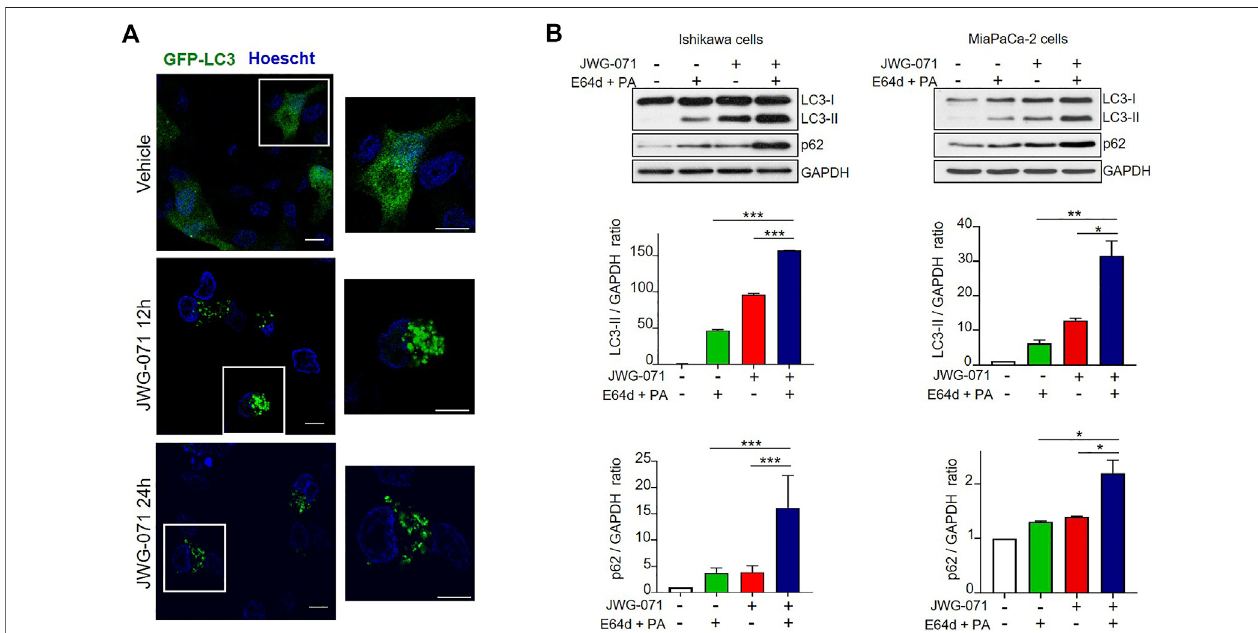
FIGURE 2 | ERK5 inhibition induces autophagic fl ux. (A) ERK5 inhibition induces LC3 association with autophagosomes. HeLa cells transiently expressing GFP- LC3 (green) were treated with vehicle or 5 μ M JWG-071 for 24 h. After staining nuclei in vivo with Hoechst 33342 (blue), cells were fi xated and visualized by confocal fl uorescence microscopy.Punctuate represents autophagosome formation. Similar resultswereobtained intwoindependentexperiments. Scalebar. 10 μ m. (B) ERK5 inhibition induces autophagic fl ux. Ishikawa and MiaPaCa-2 cells were pre-incubated for 2 h with ethanol (vehicle) or a combination of lysosomal proteases inhibitors E64d (10 μ M) and Pepstatin-A (PA, 10 mg/ml) before treatment with 5 μ M JWG-071 or DMSO for further 24 h. Cell lysates were probed against autophagy markersLC3andp62.GAPDHlevelswereassessedasaloadingcontrol.Similarresultswereobtainedintwoseparateexperiments.Histogramsshowthequanti fi cation of LC3-II levels relative to GAPDH, estimated by densitometric analysis. Values represent mean ± SD of two different determinations. * p < 0.05 ** p < 0.01, *** p < 0.001 from treatment with E64d + PA alone or JWG-071 alone.